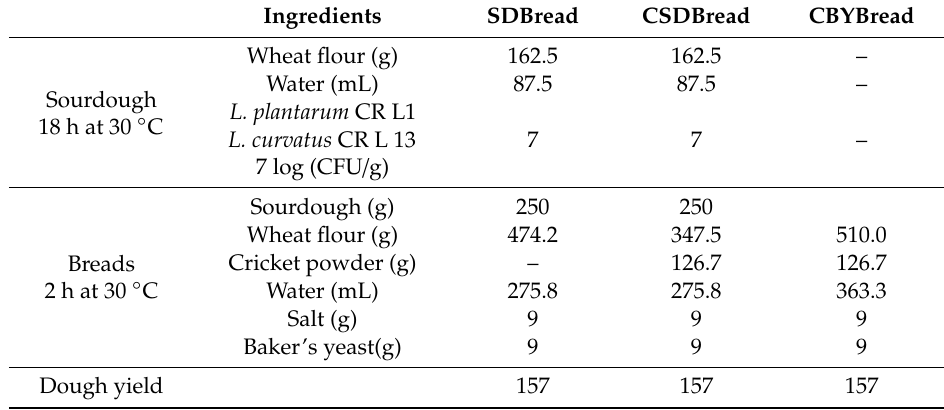
Table 1. Ingredients and fermentation conditions (time and temperature) for sourdough preparation, bread preparation, and dough yield. SDBread: bread produced by sourdough and only wheat flour; CSDBread: bread produced by sourdough and wheat flour and cricket powder; and CBYBread: bread produced by baker’s yeast and wheat flour and cricket